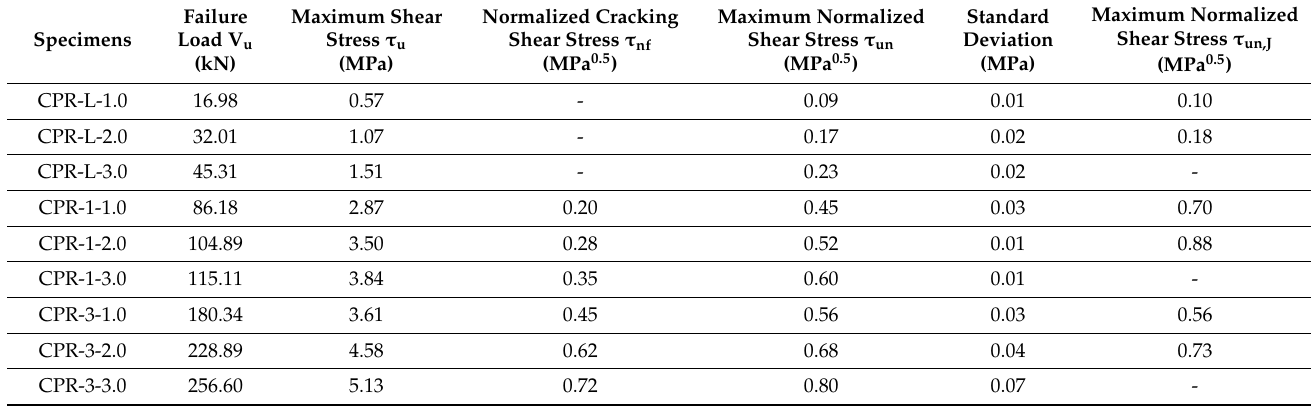
Table 8. Summary of experimental results of the RAC dry joints and the results presented by Jiang et al.